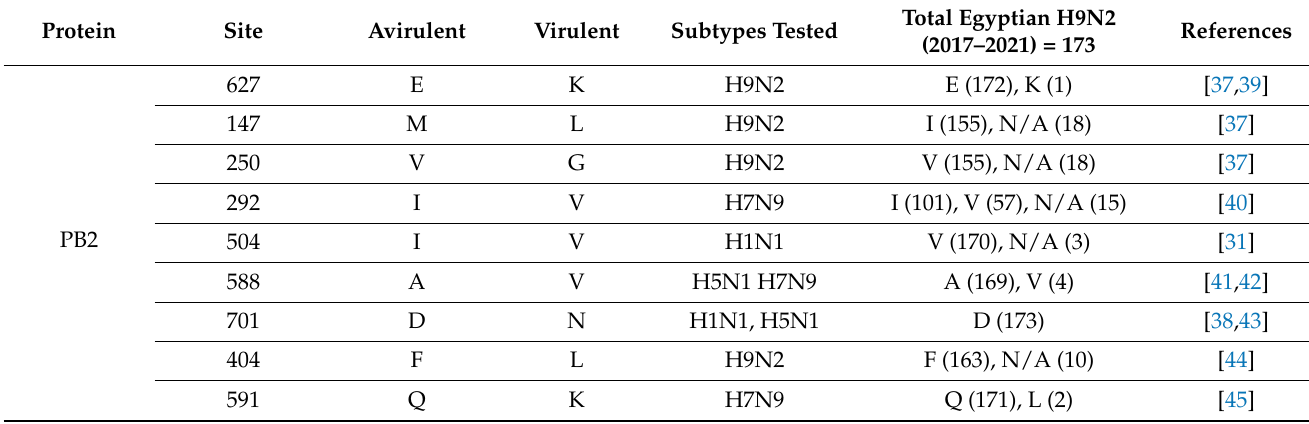
Table 1. Analysis of genetic markers associated with virulence in the viral PB2, PB1-F2, PB1, PA, NP, M1, M2, NS1, and N S2 proteins of the 173 Egyptian H9N2 viruses isolated from poultry in Egypt from 2017 to